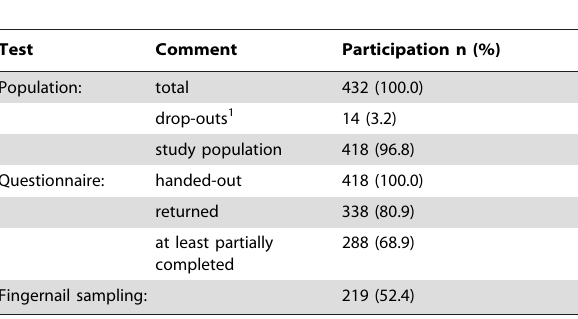
Table 2. Questionnaire and fingernail sampling response among children of the two major public schools of the